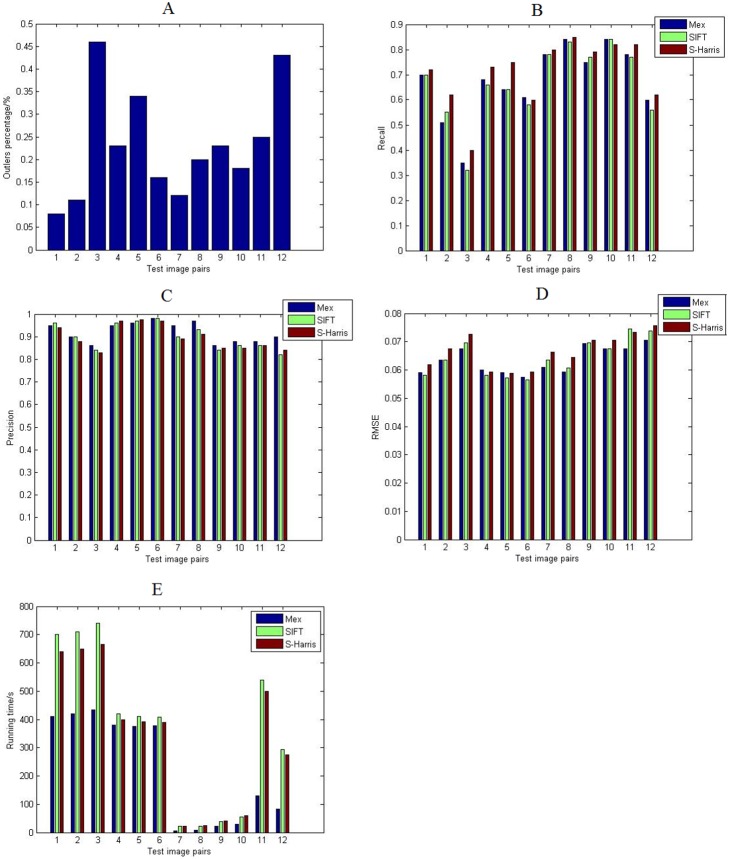
Comparison results.